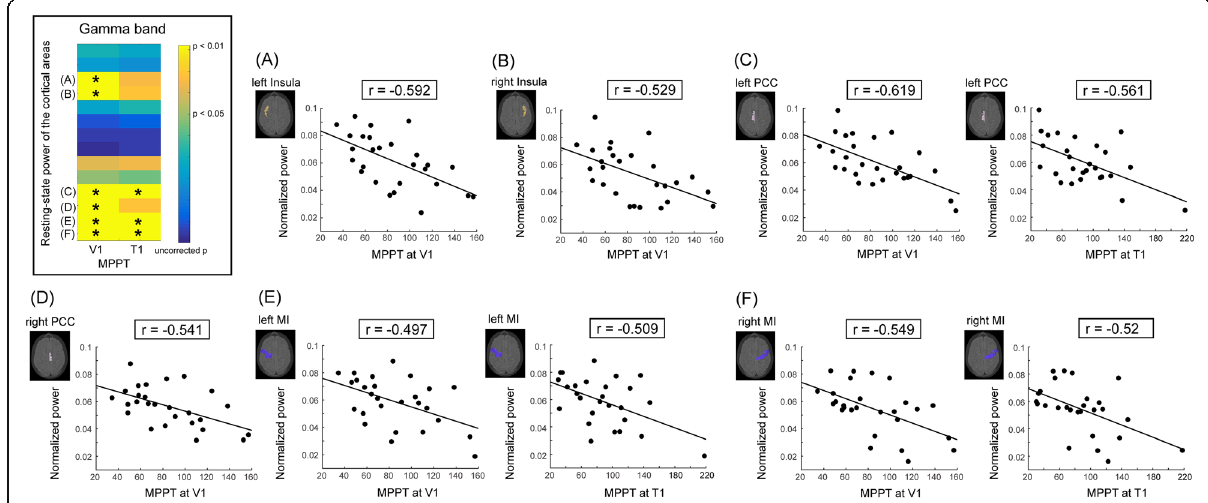
Fig. 3 Significant correlation of the mechanical punctate pain threshold with resting-state gamma activities at the ( a ) left insula, ( b ) right insula, ( c ) left PCC, ( d ) right PCC, ( e ) left MI, and ( f ) right MI in healthy individuals. * P < .05 with false discovery rate correction. MPPT, mechanical punctate pain threshold; PCC, posterior cingulate cortex; MI, primary motor cortex; V1, left supraorbital (the first branch of the trigeminal nerve dermatome); T1, proximal medio-ventral forearm (the first thoracic nerve